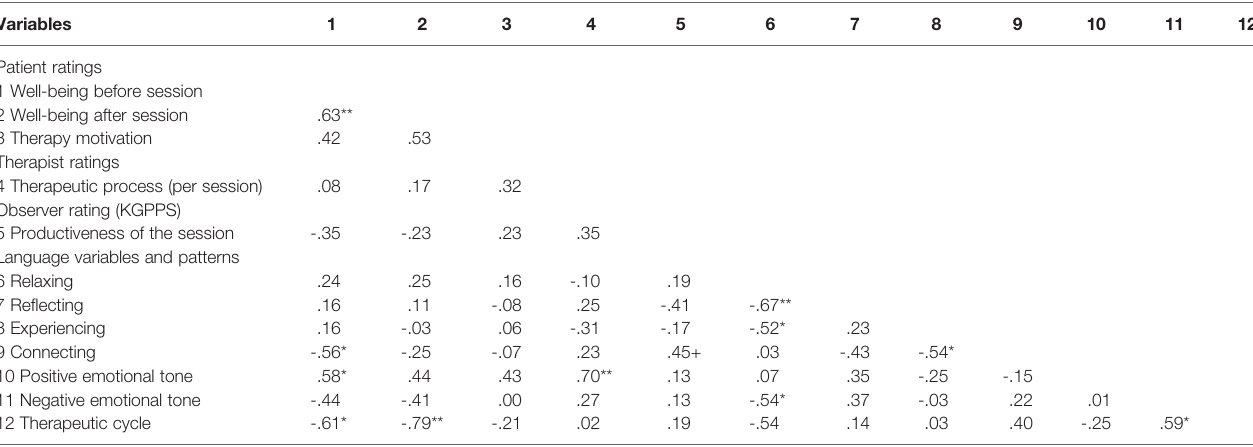
TABLE 3 | Intercorrelations between session ratings and language variables and patterns in the total